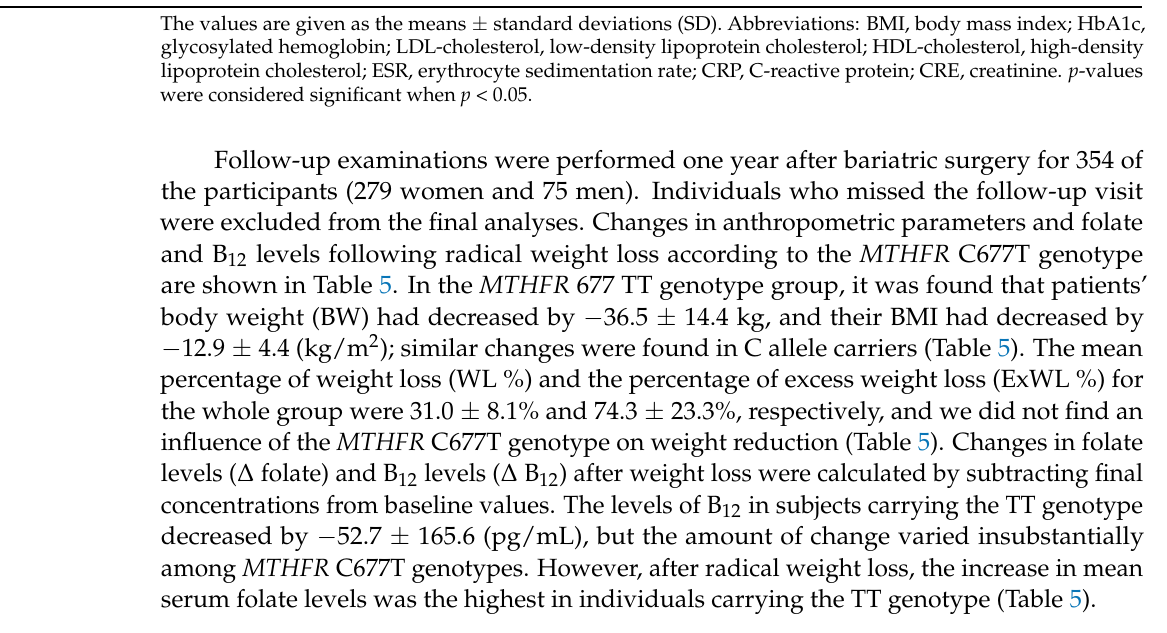
Table 5. Changes in anthropometric and biochemical parameters following radical weight reduction according to MTHFR C677T